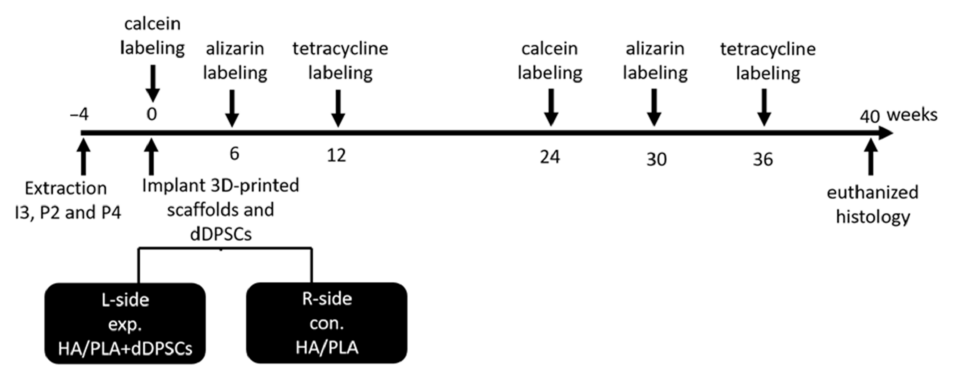
Figure 2. Outline of experiment. Animals n = 2. I3: the third incisor; P2: the second premolar; P4: the fourth premolar. exp: experimental; con: control. L-side: left side; R-side: right